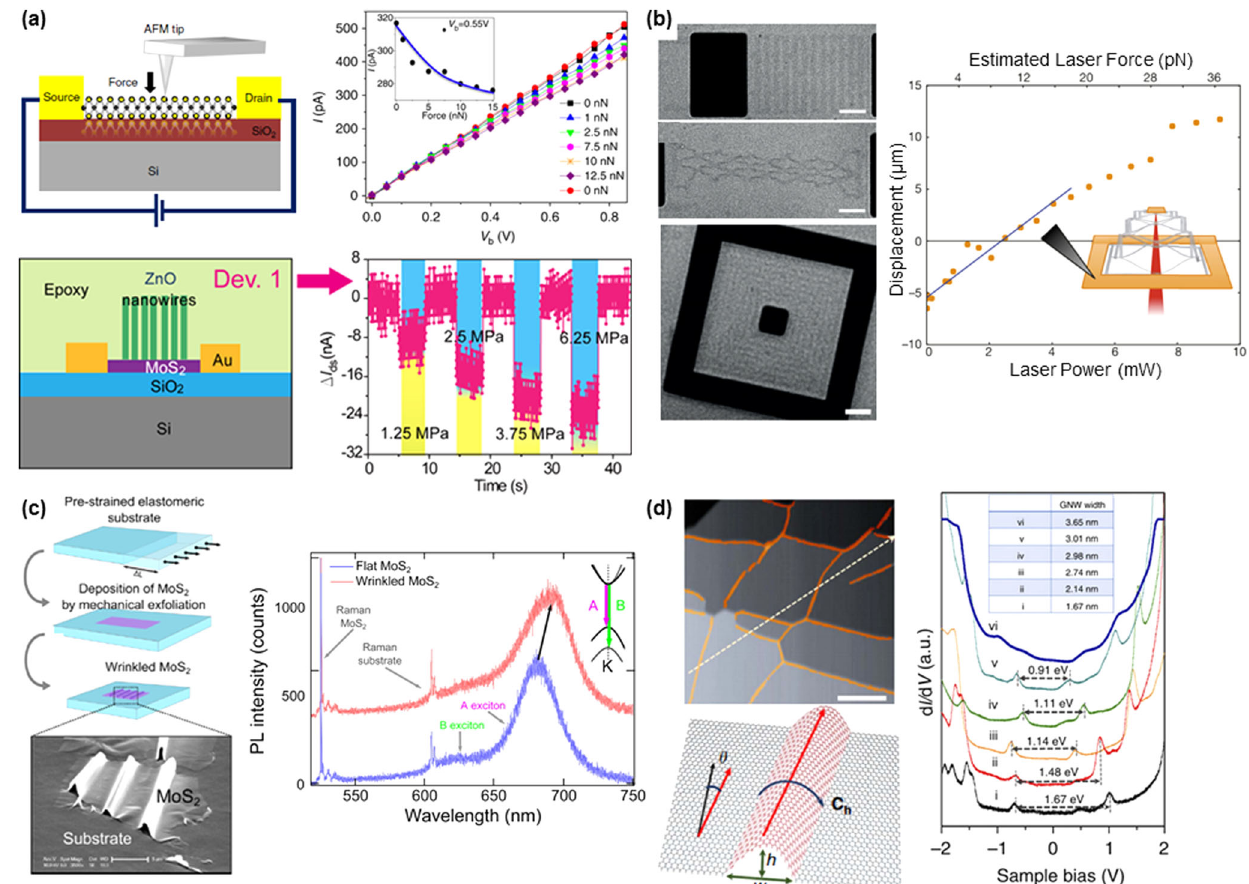
Fig. 3 Deformable 2D materials. a Schematic of FETs that are based on a MoS 2 monolayer (upper left) or a ZnO nanowire and MoS 2 monolayer hybrid structure (lower left). The right panel shows the mechanical tunable characteristics of the corresponding FETs. Reprinted with permissions from refs. 43 and 44. b Graphene kirigami in the shapes of microscale springs (upper left) and pyramids (lower left) for enhanced stretchability and deformability. Actuated by lasers, a force – distance curve for a pyramid can be obtained, from which a linear fi t at low forces yields a spring constant of 2 × 10 − 6 N m − 1 (right). Reprinted with permission from ref. 46. c Experimental steps to obtain rippled MoS 2 with an AFM image shown at the bottom (left). Photoluminescence emission measurement from the fl at (blue) and wrinkled (red) regions in the same MoS 2 fl ake shows a red shift in a wrinkled region, indicating a reduced band gap due to the local strain (right). Adapted with permission from ref. 31. d Recolored AFM image of epitaxial graphene grown on Ni (111) by a rapid cooling process, with wrinkles highlighted in orange (left, schematic drawing of the wrinkle at the bottom). dI/dV spectra obtained from graphene nanowrinkle (GNW) with different widths by scanning tunneling microscopy. The band gap marked by double dashed arrows deceases as the wrinkle width increases, due to reduced local strain. Reprinted with permission from ref.